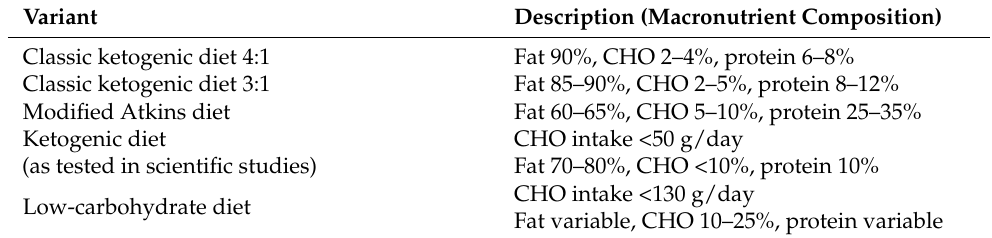
Table 3. The major types of ketogenic